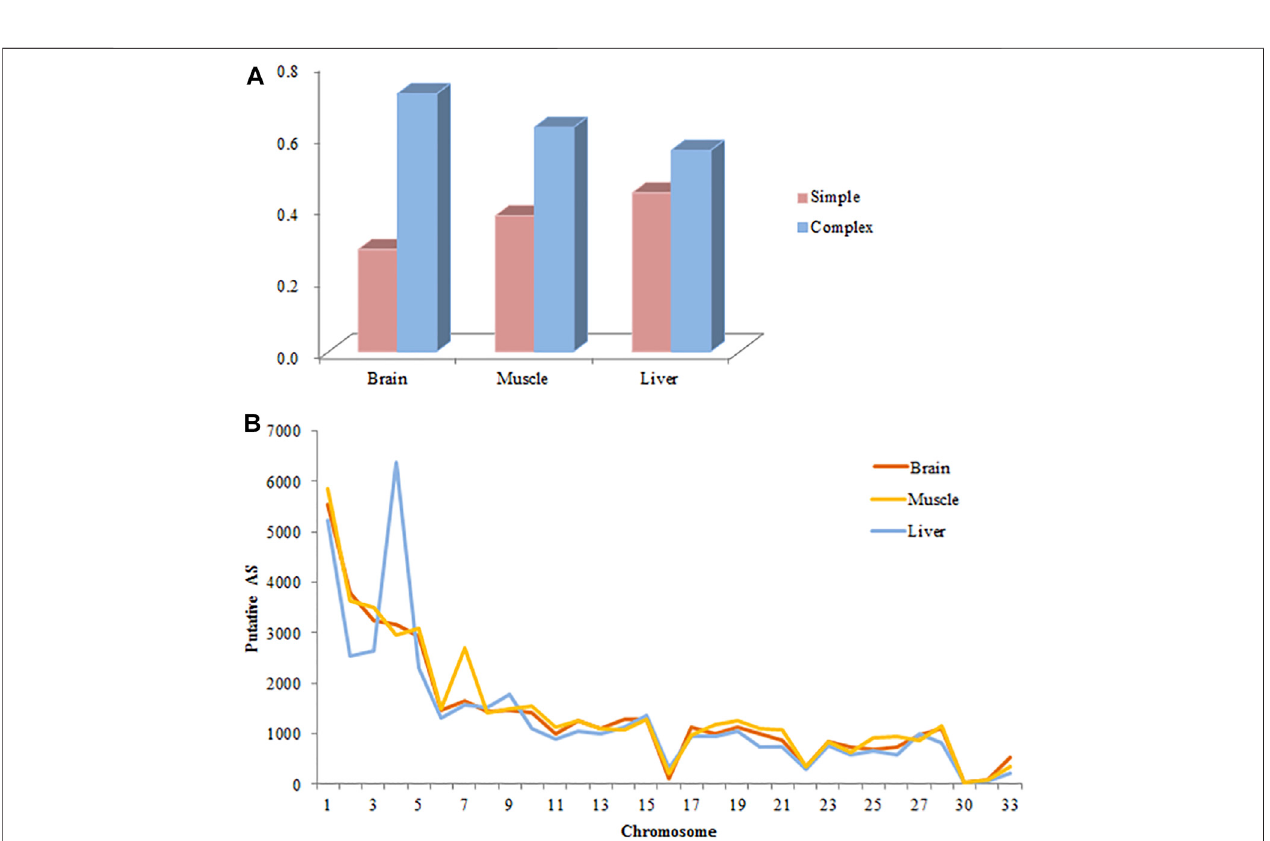
FIGURE 2 | Basic information of alternative splicing events in each tissue. (A) Complexity of AS events per gene. (B) The distribution of AS events in the chicken genome. The distribution of 45668, 47983, and 46313 putative AS events identi fi ed from brain, muscle and liver on the chicken autosomes are shown. Most of the events distributed primarily on chromosomes 1 and